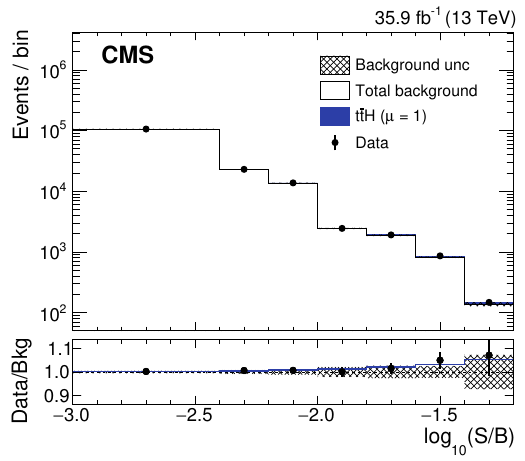
Figure 8 . Distribution in log (S = B), where S and B indicate the respective bin-by-bin yields of the 10 signal and background expected in the MEM discriminant distributions, obtained from a combined (cid:12)t with the constraint in the cross section of (cid:22) =